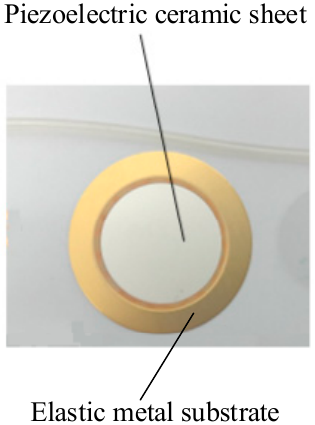
Figure 12. Structure of the wheeled check valve; ( a ) wheeled valve piece; ( b ) valve plate.